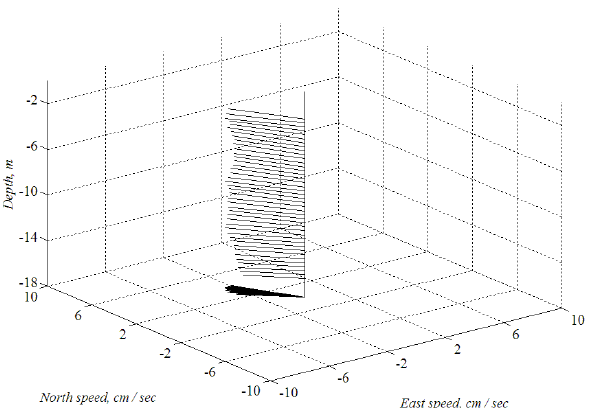
Fig. 5. Vertical structure of tidal ellipse amplitudes for the semid- iurnal (M2) frequency. Units are cm/s for the east, north speed (x, y) axes, and m for the depth-axis (z-axis).